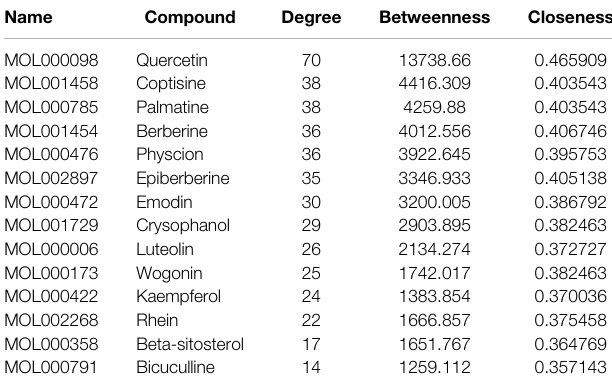
TABLE 2 | Topological parameters of the targets. TABLE 3 | Core compounds of